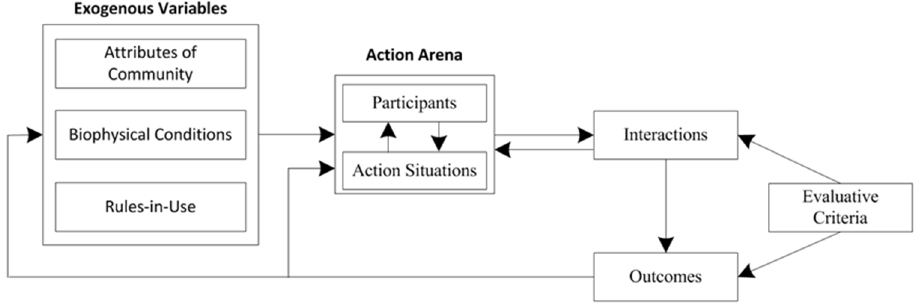
Figure 1. Institutional analysis and development framework.